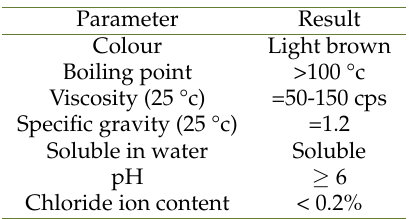
Table 2. Physical and chemical properties of